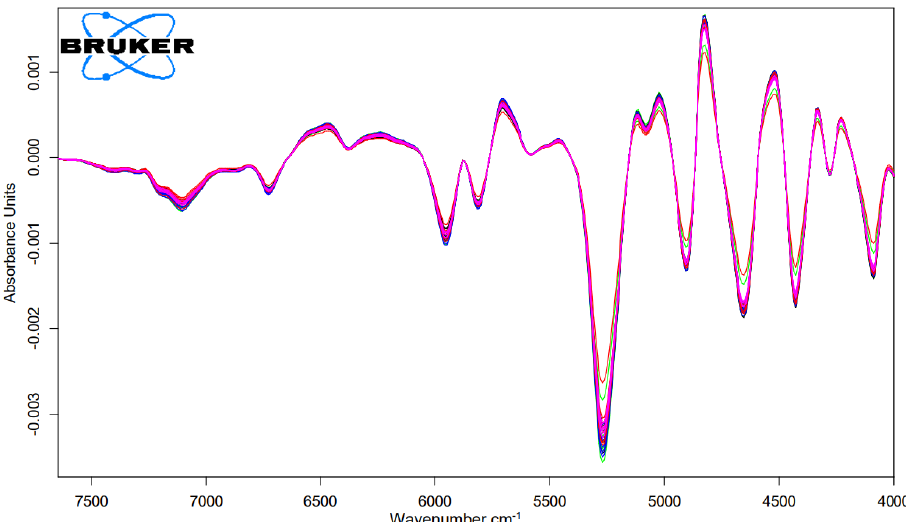
Figure 4. First derivation FT-NIR-spectra of hair tresses after 3 times bleaching and dyed with Dove Grey with n = 5.